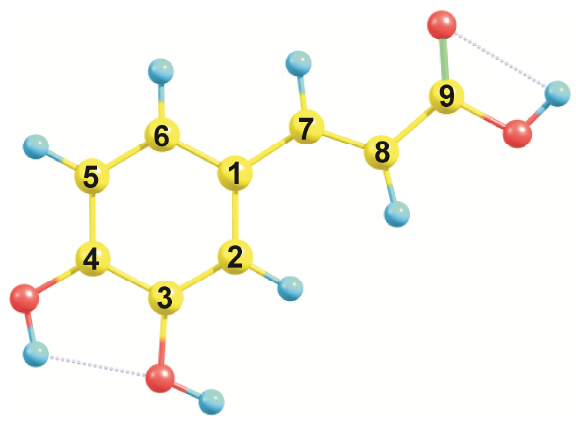
Figure 1. Structure of caffeic acid with the atom labelling